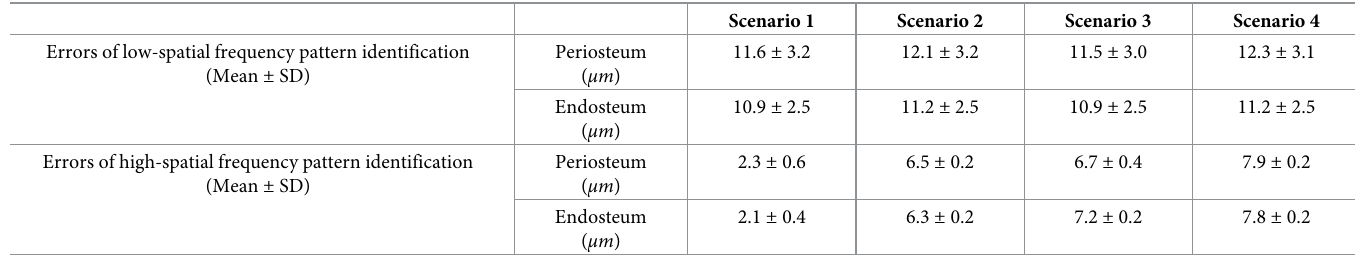
Table 1. Systematic errors in different scenarios (RMSD, N = 5 mouse). Errors of low-spatial frequency pattern identification (Mean ± SD)